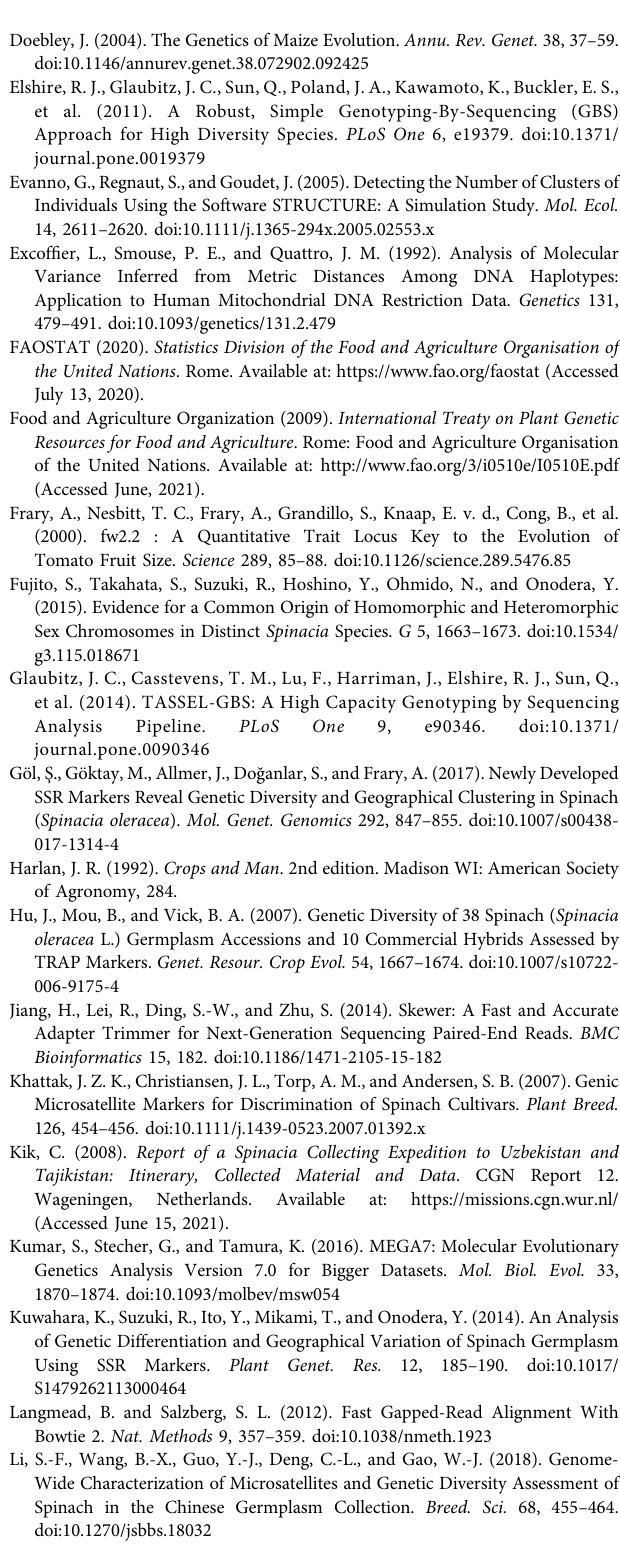
common to 16 accessions of Spinacia oleracea and 76 accessions of S. turkestanica